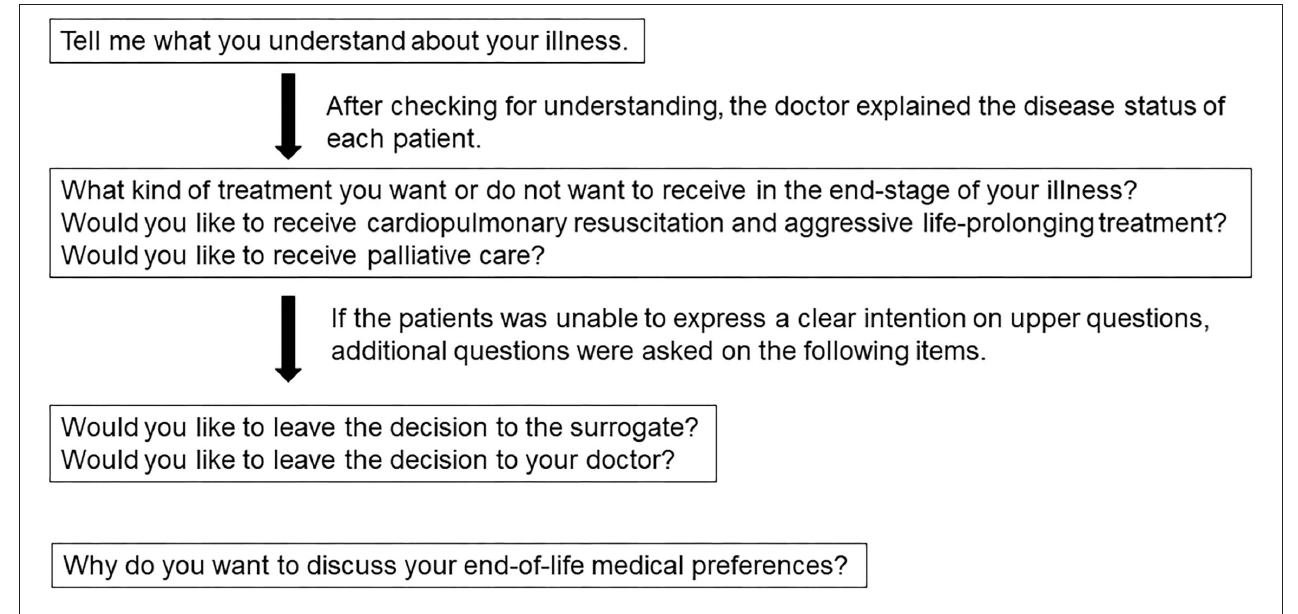
FIGURE 1 | Interview about the preferences for the end-of-life care.